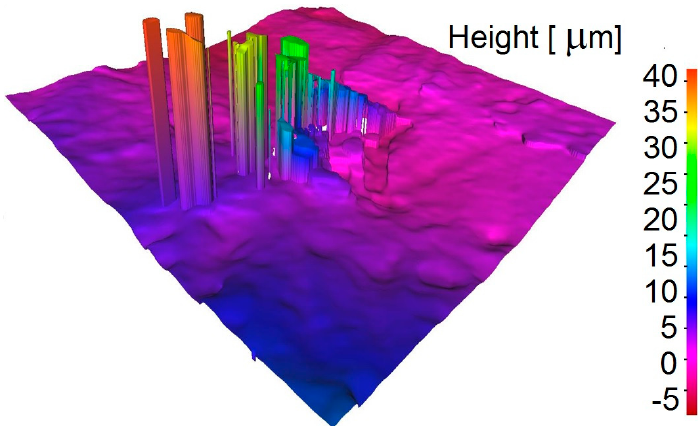
Figure 16. A detail of torn polymer fibres (protuberant out of the machined surface).